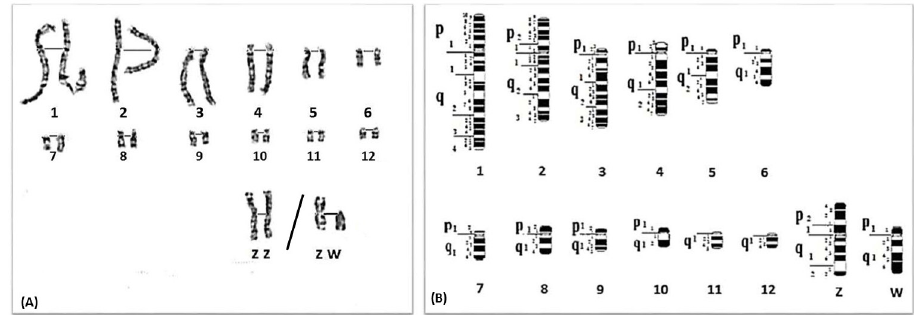
Figure 3. A GTG-banded karyotype for pairs 1 to 12 and sex chromosomes of the Japanese quail Cotur- nix japonica . B Idiogram corresponding to A